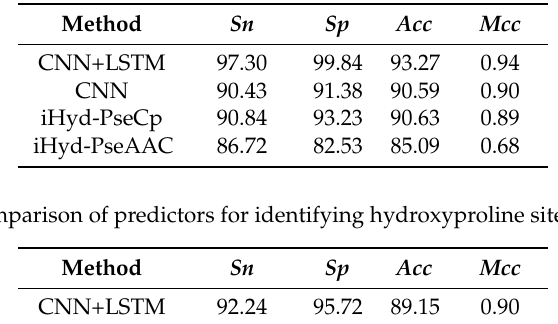
Table 2. A comparison of predictors for identifying hydroxylysine sites on Dataset 2.